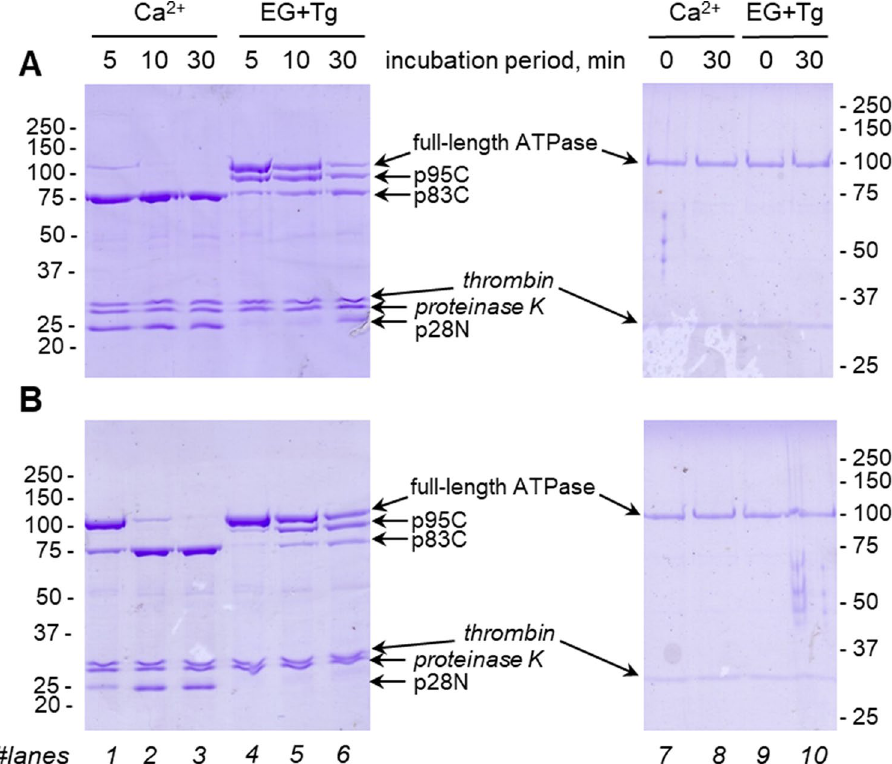
Figure 3. Effect of SLN during proteinase K treatment of recombinant purified SERCA1a (recS1a). ( A ) without SLN; ( B ) with palmitoylated SLN. Proteinase K proteolysis was performed in the presence of either 1 mM calcium (lanes 1–3) (cleavage at T242-E243) or EGTA and Thapsigargin (EG + Tg) (lanes 4–6) (cleavage at L119-K120) for 5 to 30 min before loading on SDS-PAGE as mentioned in the Methods section. Samples were also incubated for 30 min at 20 °C in absence of Proteinase K as standard, either in presence of 1 mM calcium (lanes 7–8) or EGTA and Tg (lanes 9–10), to assess the stability of the DDM-solubilized proteins. Thrombin, used for elution from the affinity chromatography resin, is present in the purified